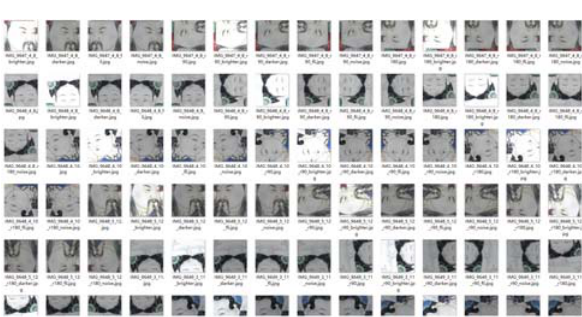
Figure 5 . mural linear feature restoration dataset